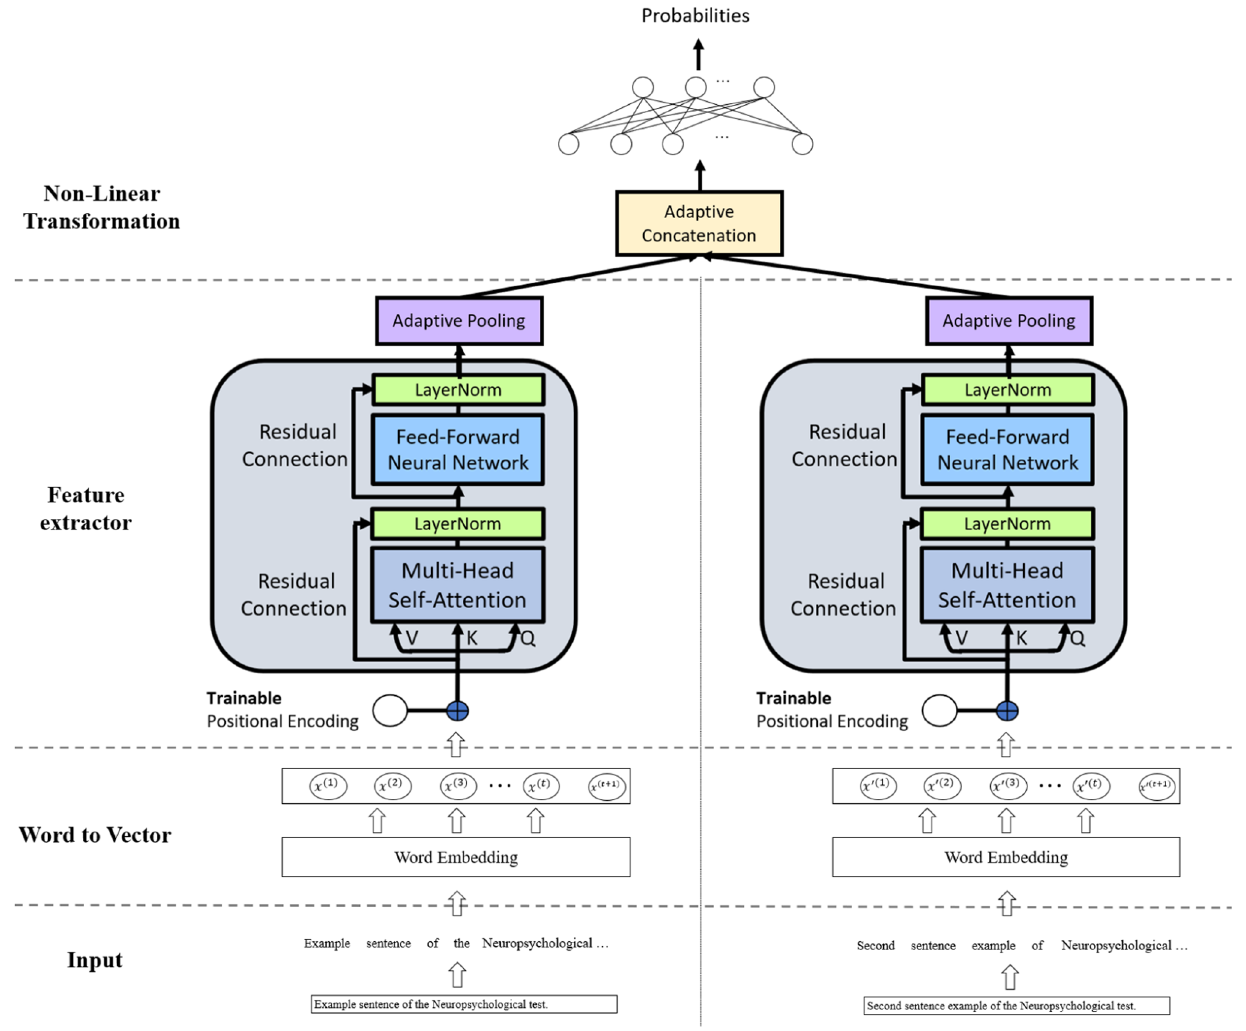
Figure 4. Screening engine using two neuropsychological tests.